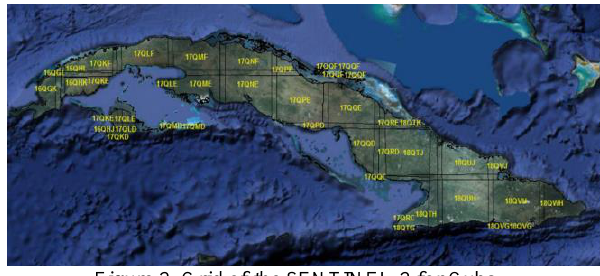
Figure 2. Grid of the SENTINEL 2 for